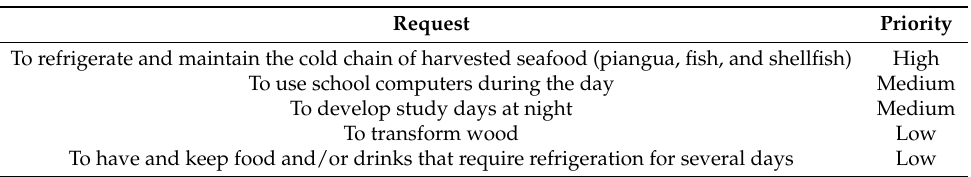
Table 8. Energy needs expressed by the residents of the La Plata, La Sierpe, Mangaña, and Miramar Villages [46].